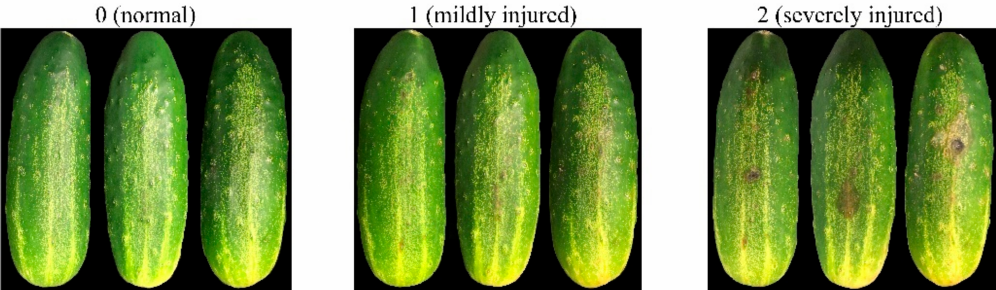
Figure 2. Examples of pickling cucumbers with three chilling injury